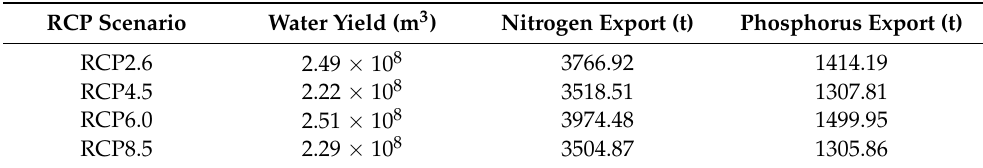
Table 1. Water yield, nitrogen and phosphorus export of Bosten Lake basin in 2050 for RCP scenarios.